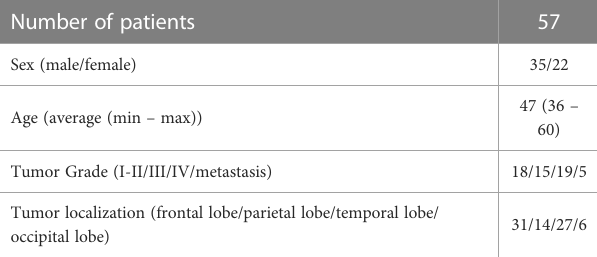
TABLE 1 The characteristics of patients included in the